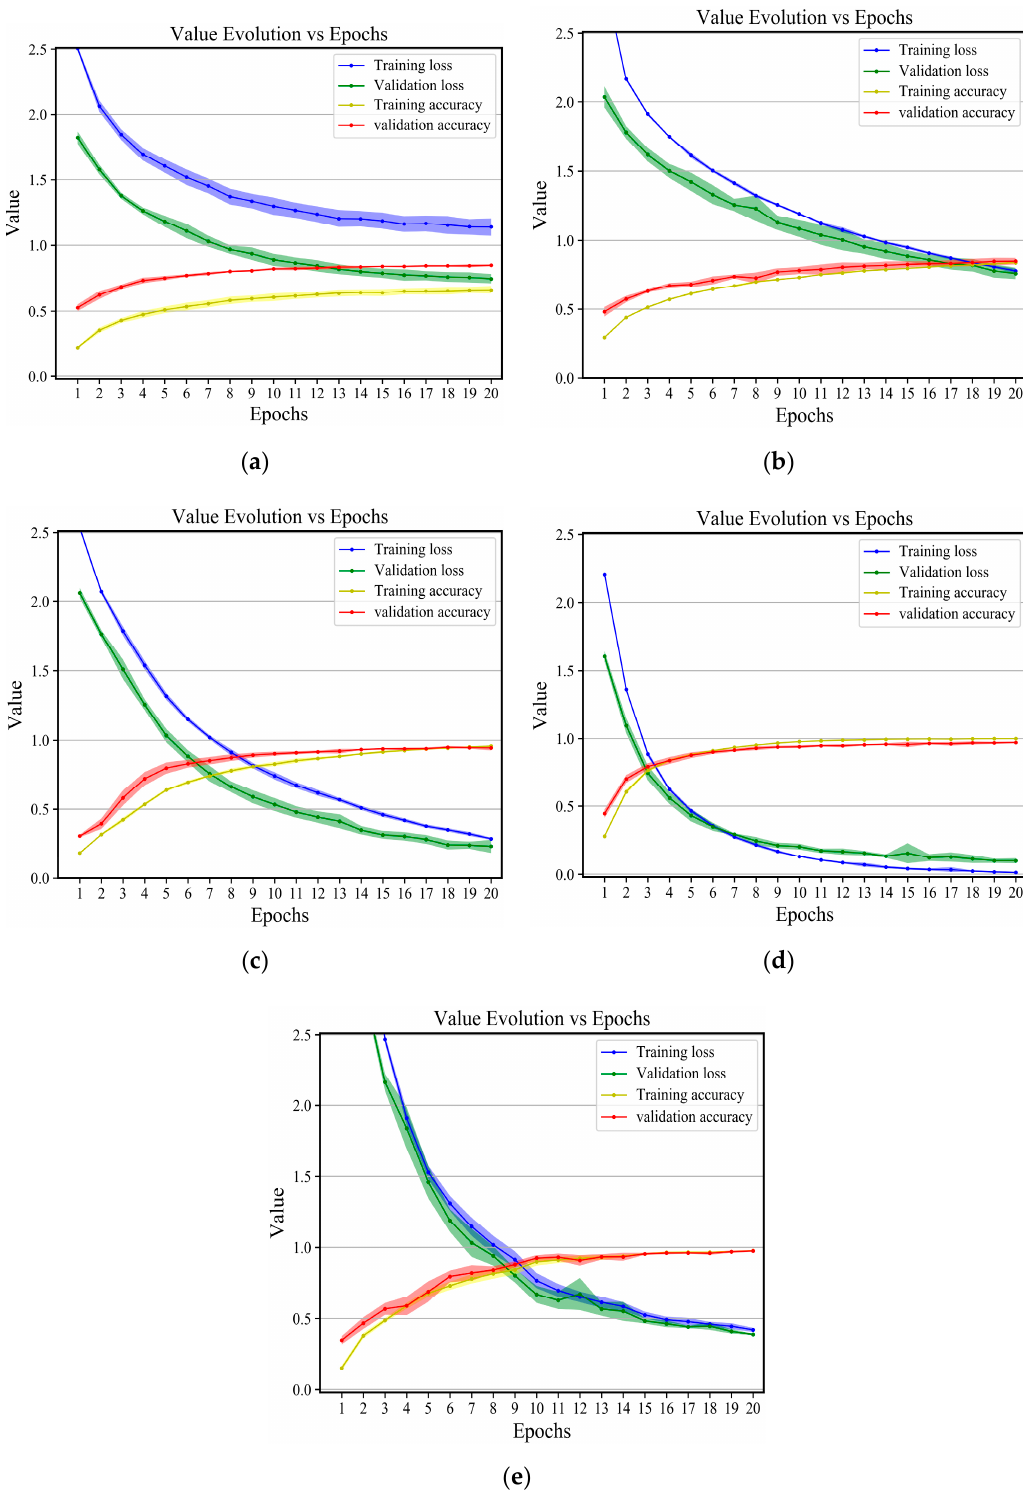
Figure 20. Indiana Pines dataset: Evolution of the accuracy or loss in terms of epochs on training and validation data. The shadow shows the standard deviation of the values for five executions: ( a )